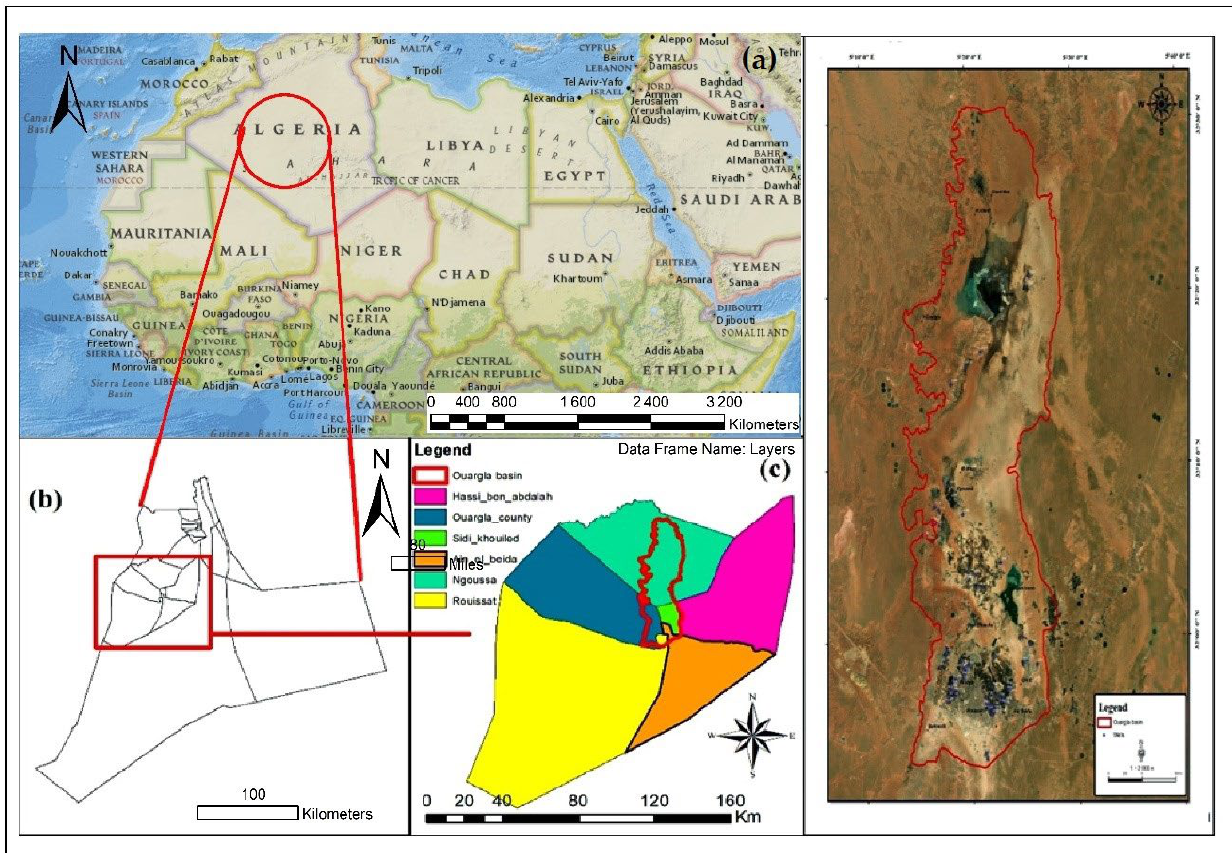
Figure 1. Geographical location of ( a ) Algeria, ( b ) Ouargla city and ( c ) Ouargla basin. Eocene evaporitic: it is a legionnaire formation made up of limestones, clays, marls, and anhydrite. It is not porous and separates the carbonated Eocene sands from the Mio Pliocene